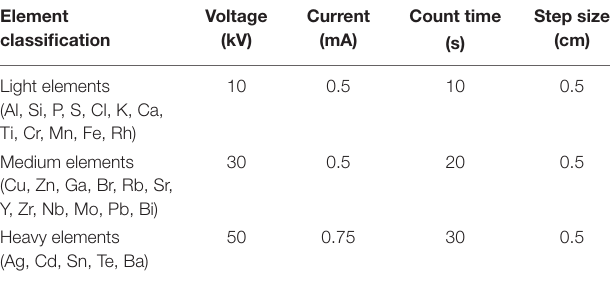
TABLE 1 | Range of options to optimize scanning conditions for the